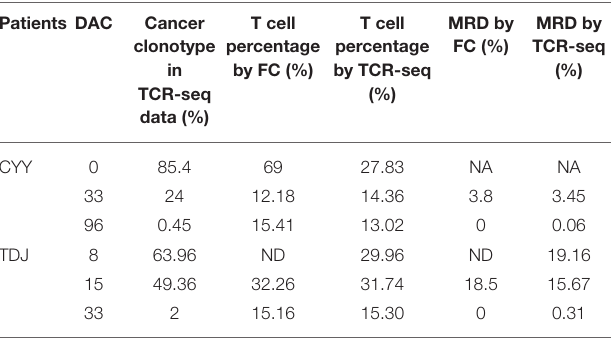
TABLE 1 | Comparing MRD detection results by TCR-seq and FC of T-ALL patients. Patients